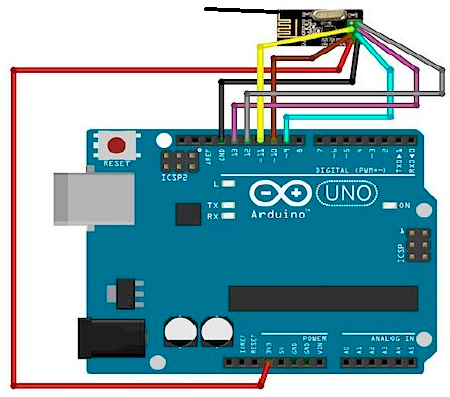
Figure 13. Proof of concept sensor and UAV node.